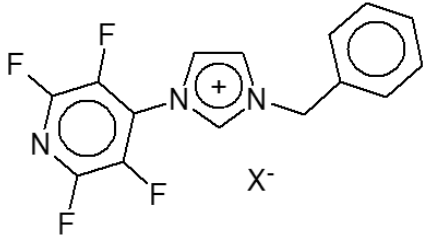
Table 1. Crystallographic data for 1-(2,3,5,6-tetrafluoropyridyl)-3-benzylimidazolium chloride ( 1 ) and iodide ( 3 ) 1